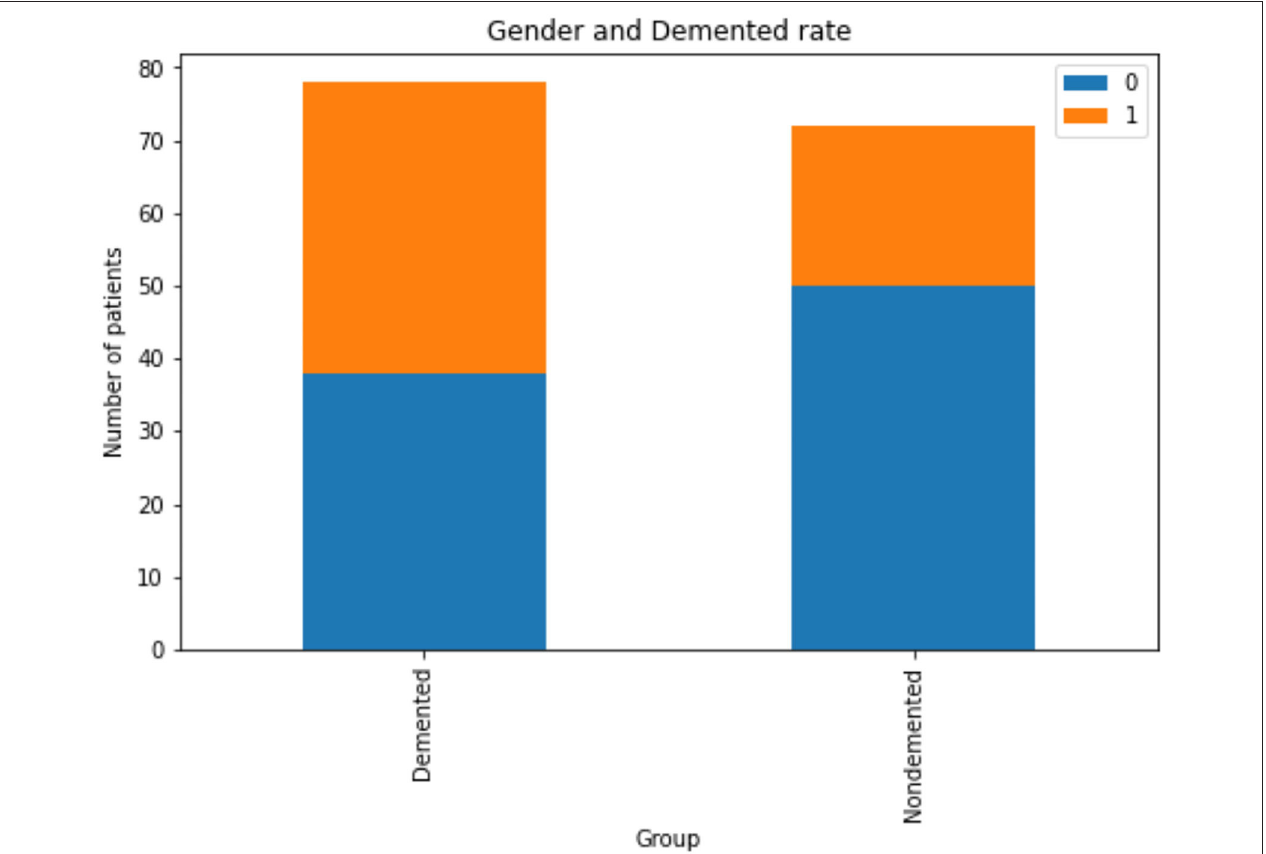
FIGURE 3 | Analysis of demented and non-demented rate based on gender, Gender group Female = 0, Male = 1.